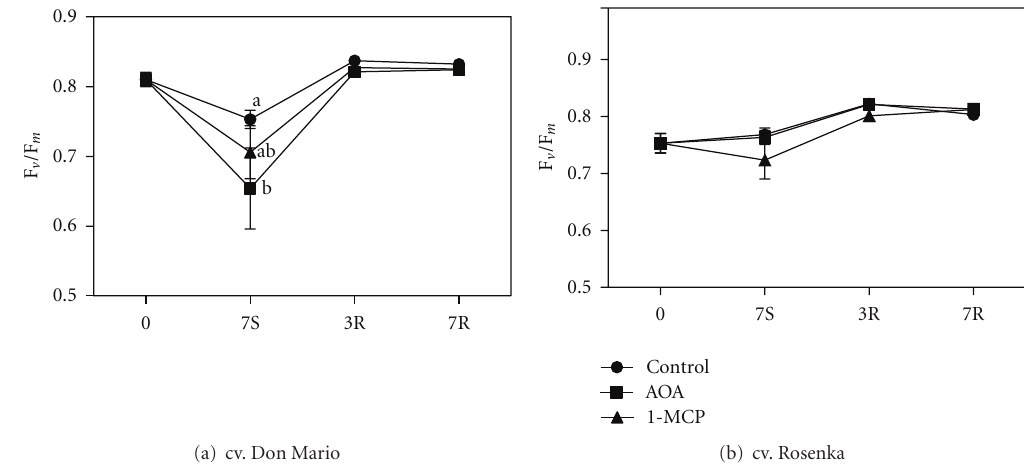
Figure 5: Maximum quantum e ffi ciency of photosystem II (F v / F m ) from leaves of cv. Don Mario (a) and cv. Rosenka (b) stored for 7 days (7S) at 14 ◦ C and transferred at 20 ◦ C for recovery evaluation (3R and 7R). Values are means with standard errors ( n = 10). Data were subjected to one-way ANOVA, and di ff erent letters, when present, mean that values are statistically di ff erent, P < 0 . 05.